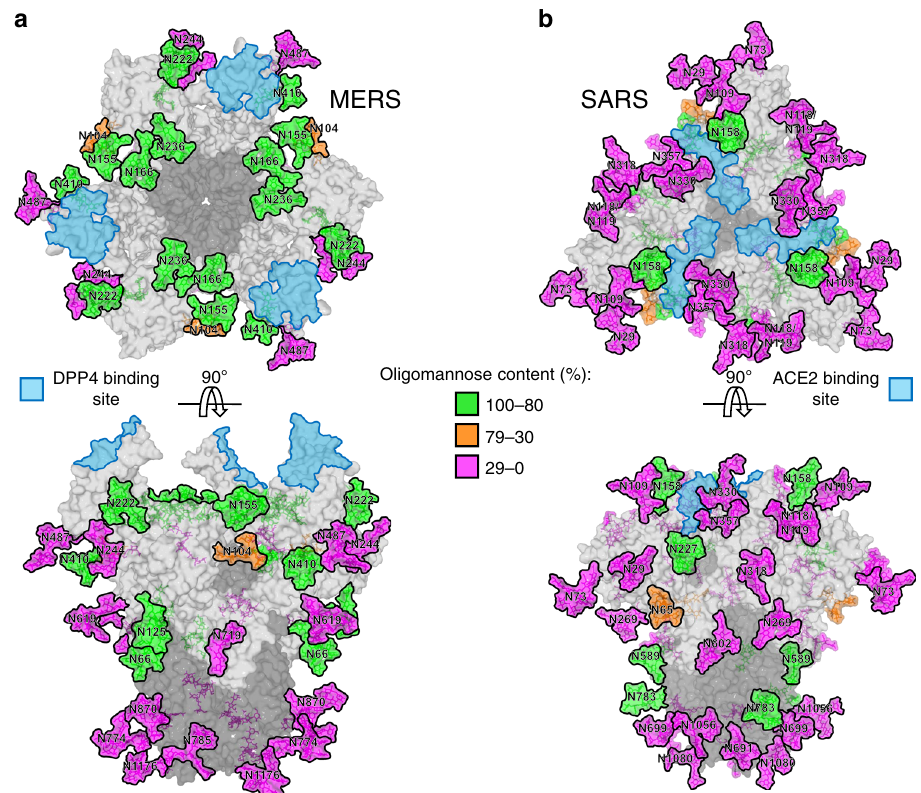
Fig. 3 Structure-based mapping of N-linked glycans on MERS and SARS S proteins. The modelling of the experimentally observed glycosylation is illustrated on the prefusion structure of trimeric a MERS S (PDB ID 5X59) 11 and b SARS S (PDB ID 5X58) 11 glycoproteins. Structural-based mapping of N- linked glycans on a MERS and b SARS S proteins. The modelling of the experimentally observed glycosylation is illustrated on the prefusion structure of trimeric MERS S (PDB ID 5X59) 11 and SARS S (PDB ID 5X58) 11 glycoproteins. The glycans are colored according to oligomannose content, as de fi ned by the key. DPP4 receptor-binding sites and ACE2 receptor-binding sites for MERS and SARS, respectively, are indicated in light blue. The S1 and S2 subunits are colored light grey and dark grey,